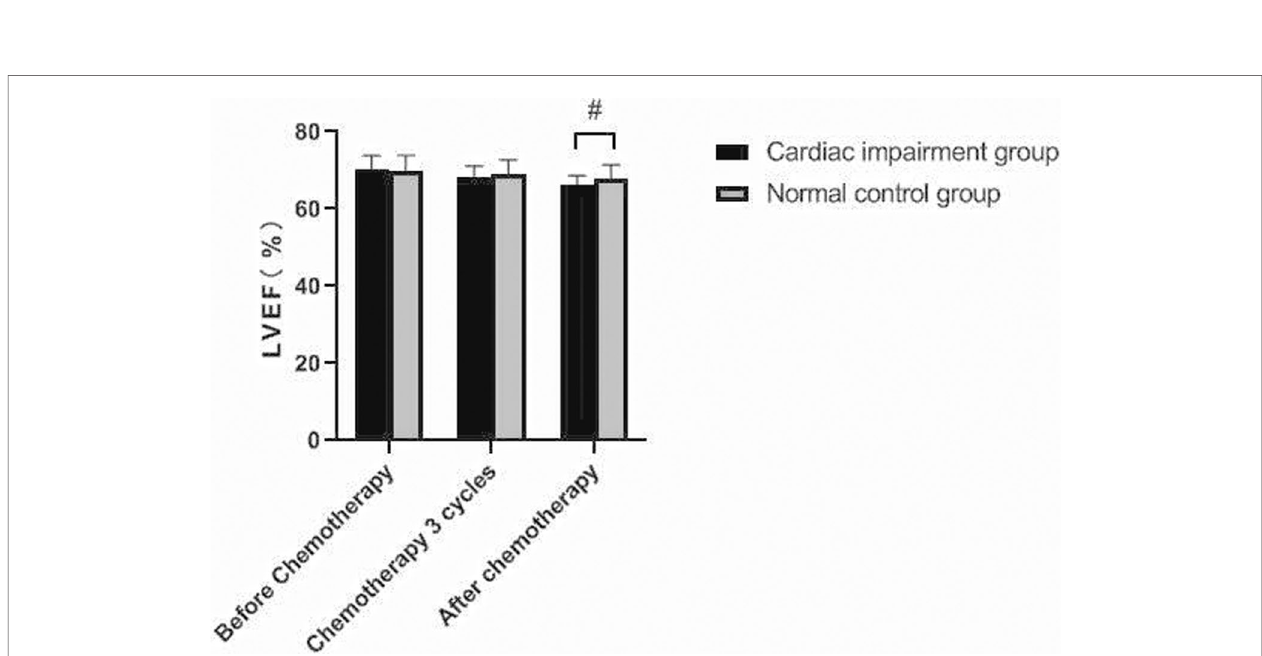
FIGURE 5 | Comparison of LVEF values between the two groups at different time points. Note: Compared with the normal control group, # P